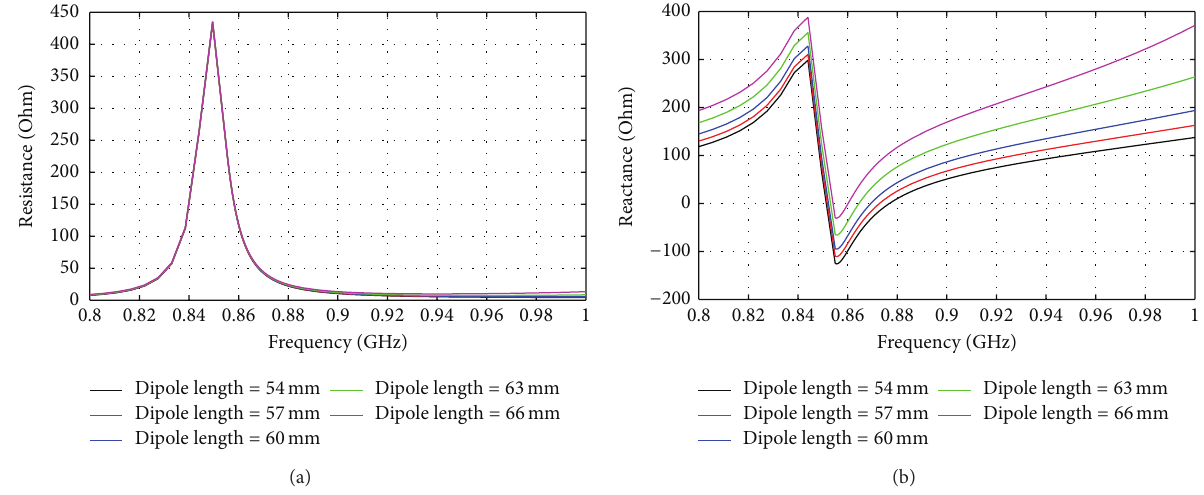
Figure 7: Tuning the real and imaginary parts of the input impedance by varying the length of the excitation dipole.